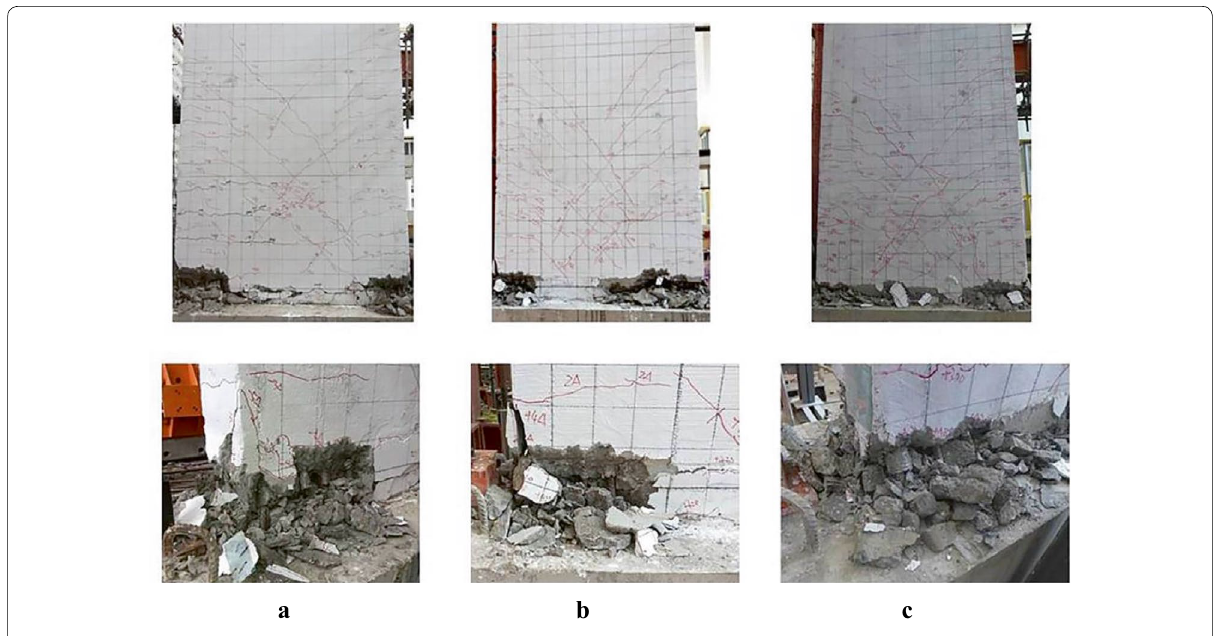
Fig. 6 Final crack pattern and failure mode of a Z‑1, b Z‑2, c